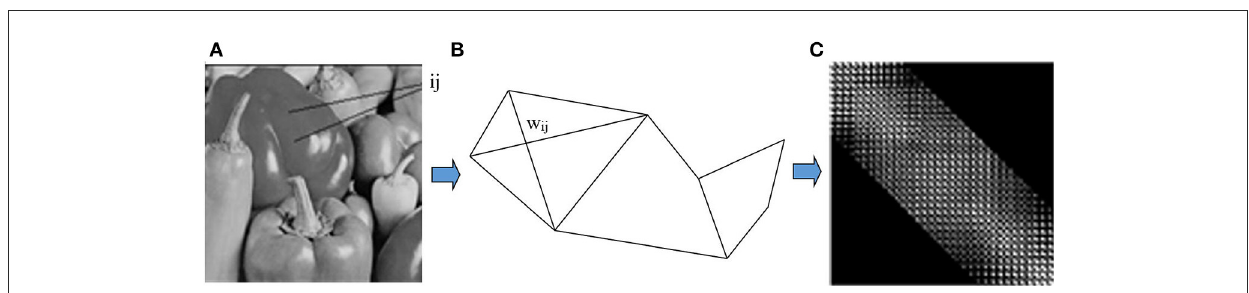
FIGURE2 The graph and the similarity of original image: (A) Original image. (B) Grap G. (C) Matrix affinity W.